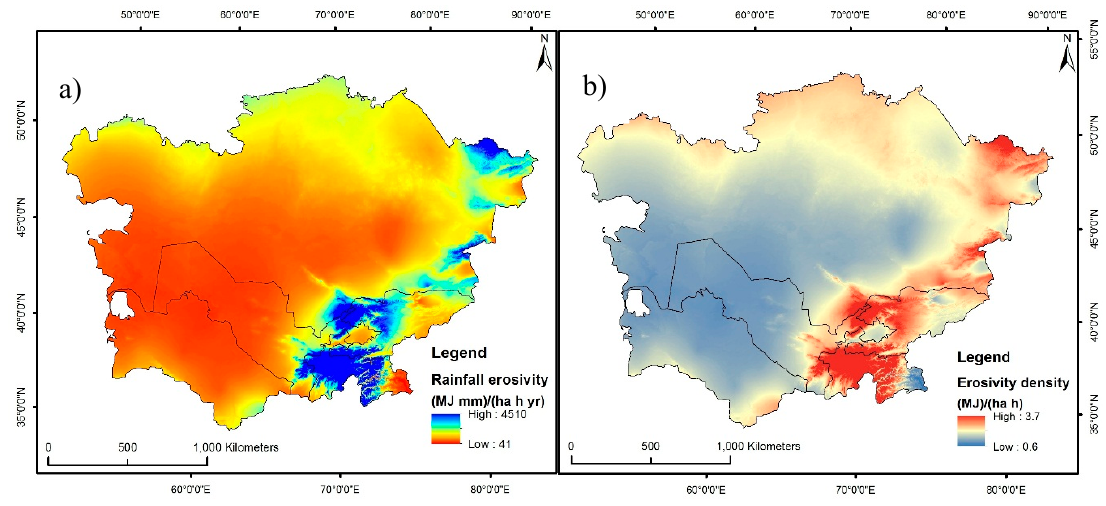
Figure 4. ( a ) Baseline rainfall erosivity and ( b ) erosivity density.